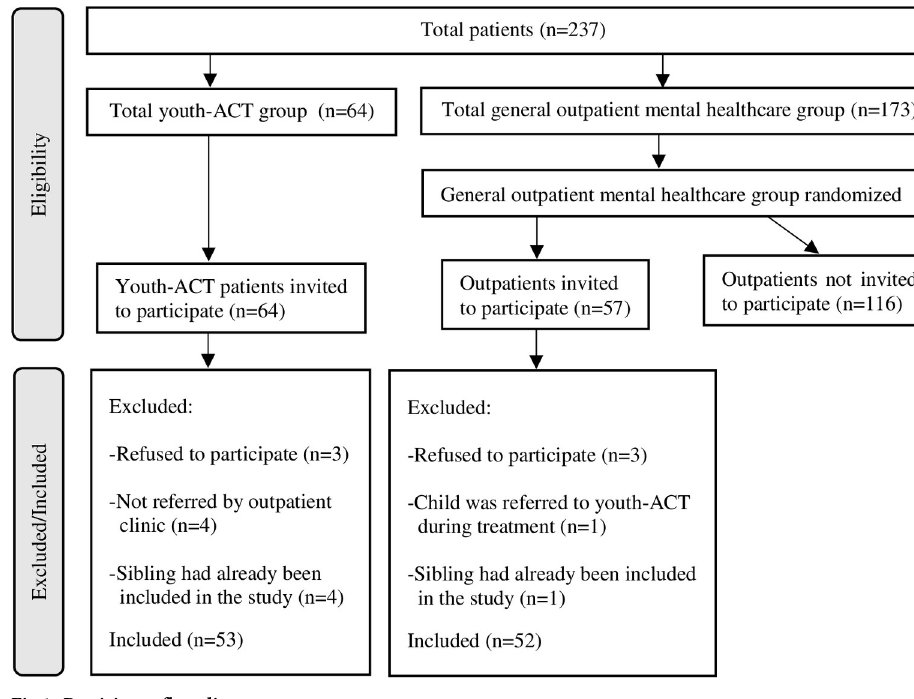
Fig 1. Participant flow